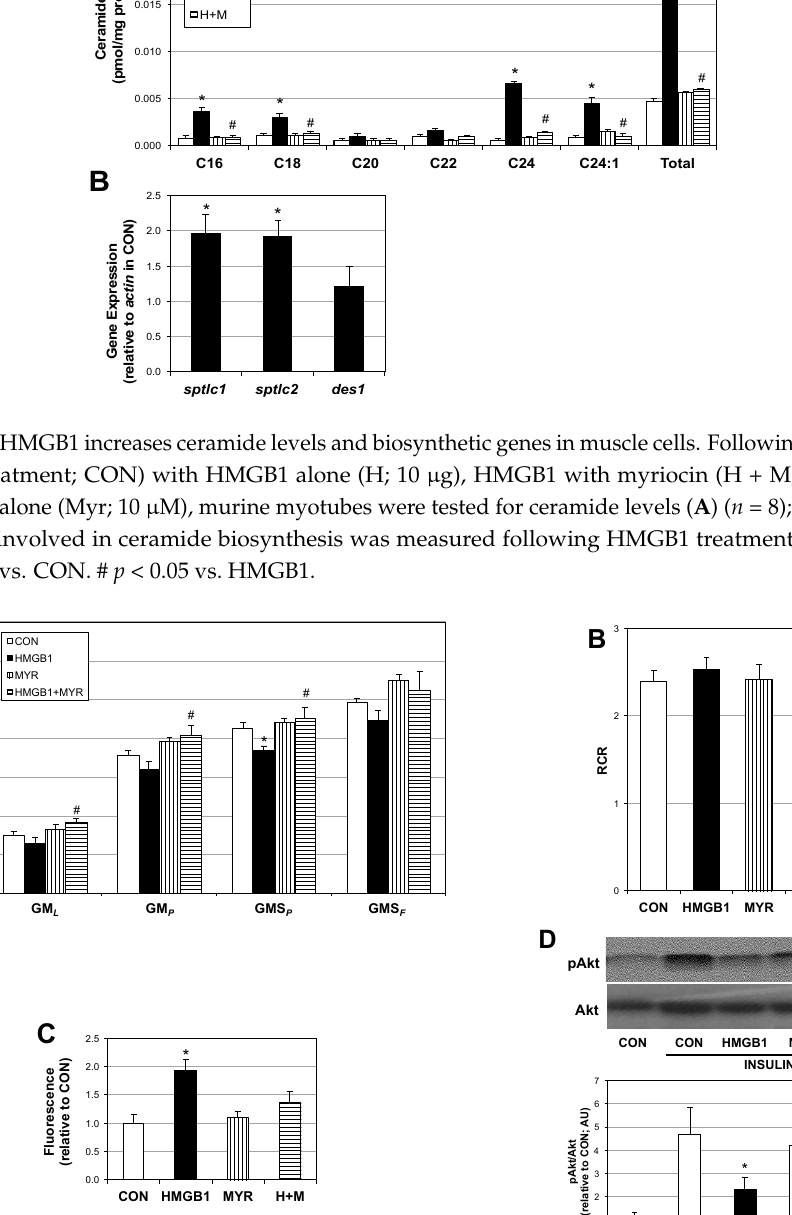
Figure 4. HMGB1 disrupts mitochondrial function and insulin signaling in a ceramide-dependent manner. Cells were incubated in control (CON) conditions, or with HMGB1 alone (10 μ g), HMGB1 with myriocin (H + M; 10 μ M) or myriocin alone (Myr; 10 μ M). To measure mitochondrial respiration ( A ) ( n = 4–5); cells were treated with: GM L : Glutamate (10 mM) + Malate (2 mM); GM P : + ADP (2.5 mM); GMS P : + Succinate (10 mM); GMS F : + FCCP (0.05 μ M). Respiratory control ratio was determined by GM L /GM P ( B ) ( n = 4–5); Production of reactive oxygen species ( C ) ( n = 3) was determined via dichlorofluorescin (DCF) assay. * p < 0.05 vs. CON. Insulin signaling ( D ) ( n = 4) via Akt phosphorylation (Ser-473) was determined by treating cells with insulin (100 nM) for 10 min prior to lysing. * p < 0.05 vs. CON. # p < 0.05 vs. HMGB1.